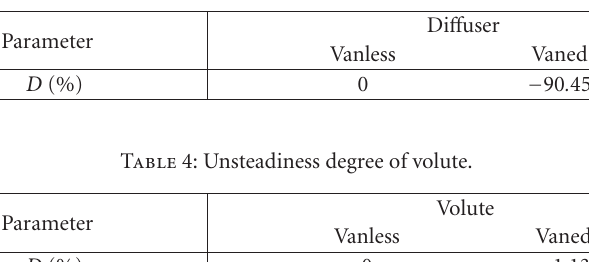
Table 3: Unsteadiness degree of di ff user.